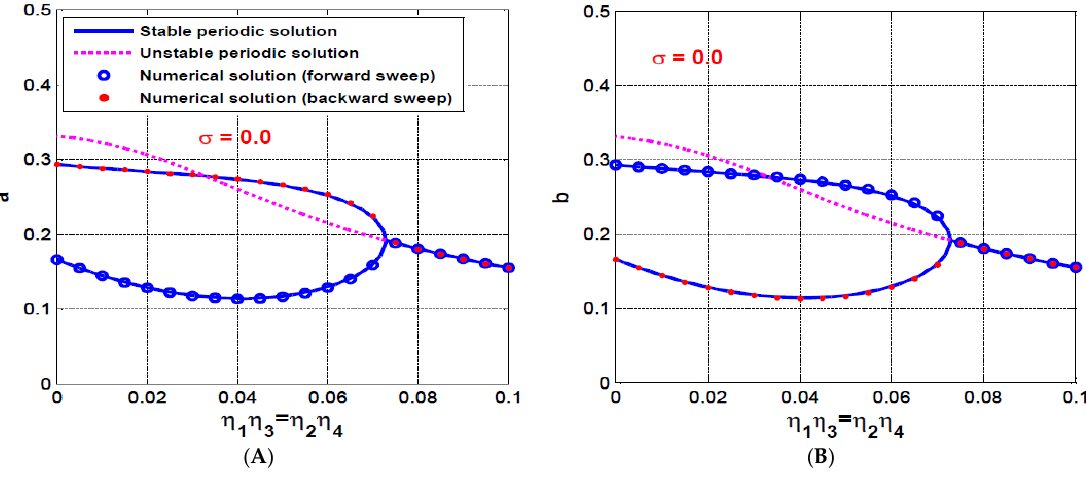
Figure 15. The rotor system 𝜂 1 𝜂 3 = 𝜂 2 𝜂 4 — response curve when 𝜎 = 0.0 : ( A ) steady-state oscillation amplitude a in 𝑋— direction, and ( B ) steady-state oscillation amplitude b in 𝑌— direction. It has been concluded before that the coupling of the IRCs to the rotor system modi- fied the rotor linear damping coefficient ( 𝜇 ) to the equivalent damping coefficients 𝜇 𝑥 = 𝜇 + 𝜂 1 𝜂 3 and 𝜇 𝑦 = 𝜇 + 𝜂 2 𝜂 4 . In addition, the detuning parameter ( 𝜎 ) has been mod- 2(𝜆 12 +𝜔 2 ) 2(𝜆 22 +𝜔 2 ) ified to 𝜎 𝑥 = 𝜎 + 𝜆 1 𝜂 1 𝜂 3 and 𝜎 𝑦 = 𝜎 + 𝜆 2 𝜂 2 𝜂 4 . Accordingly, the influence of internal 2𝜔(𝜆 12 +𝜔 2 ) 2𝜔(𝜆 22 +𝜔 2 )